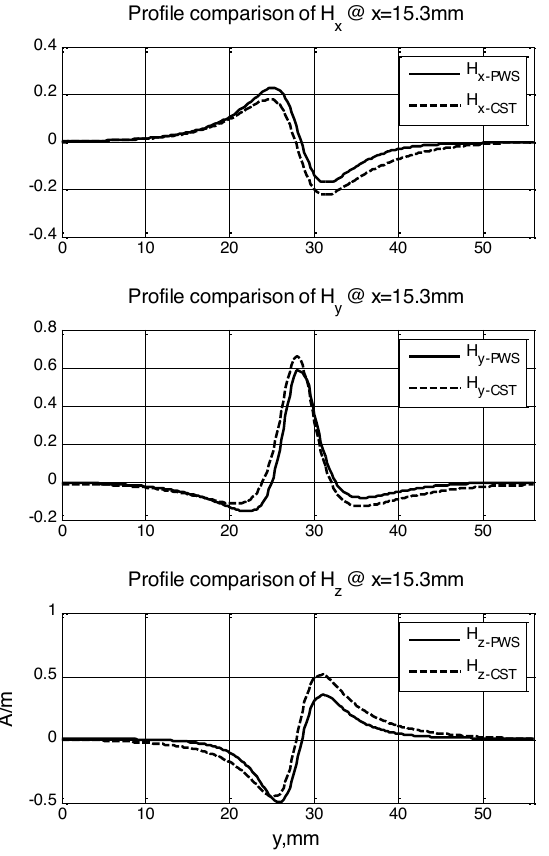
Figure 22: Comparisons of the magnetic field components profiles obtained from the proposed PWS computation method and the CST simulation, detected in the vertical cut- plan x =